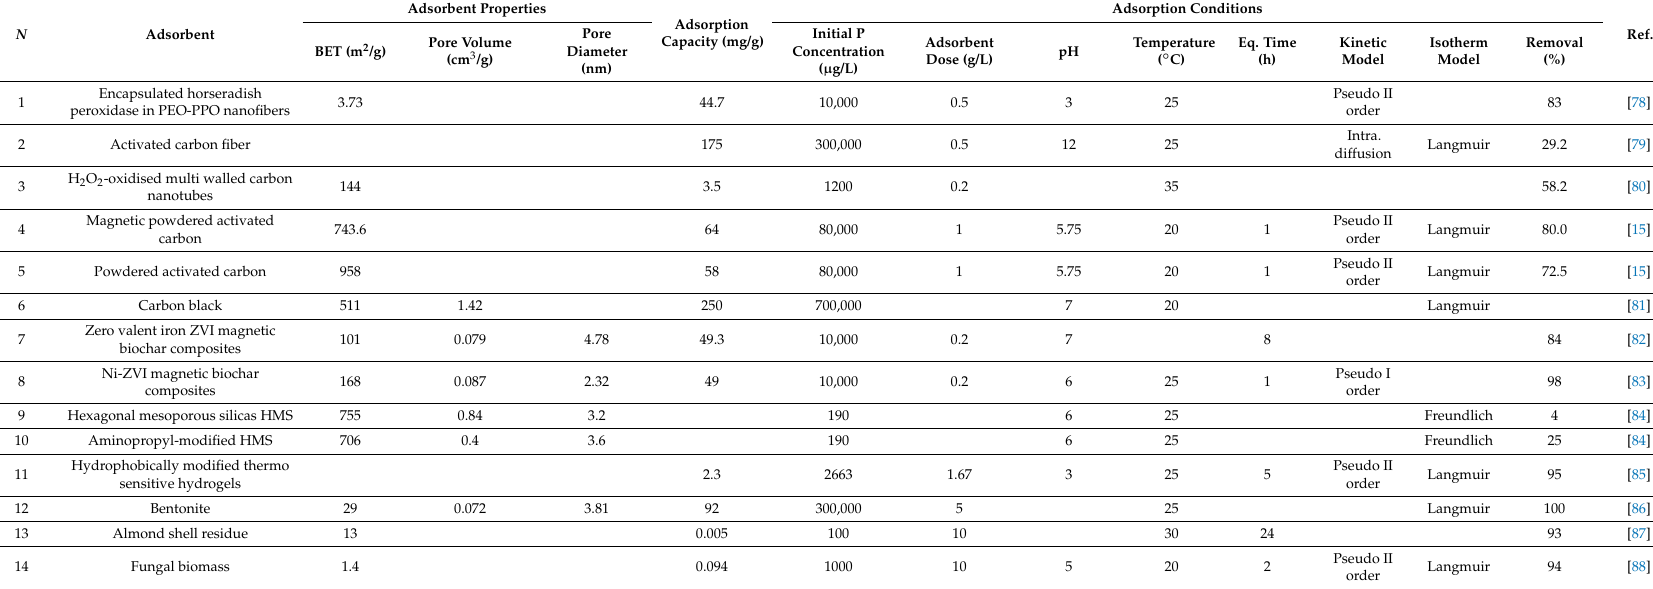
Table 9. Nanofibrous adsorbent properties and adsorption conditions for the removal of